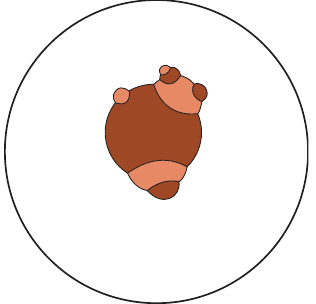
Figure 6.2 . The generating curve for a nonstandard area-minimizing dou- ble bubble in which the exterior intersects the entire axis of revolution; the bubble consists entirely of toroidal bands.